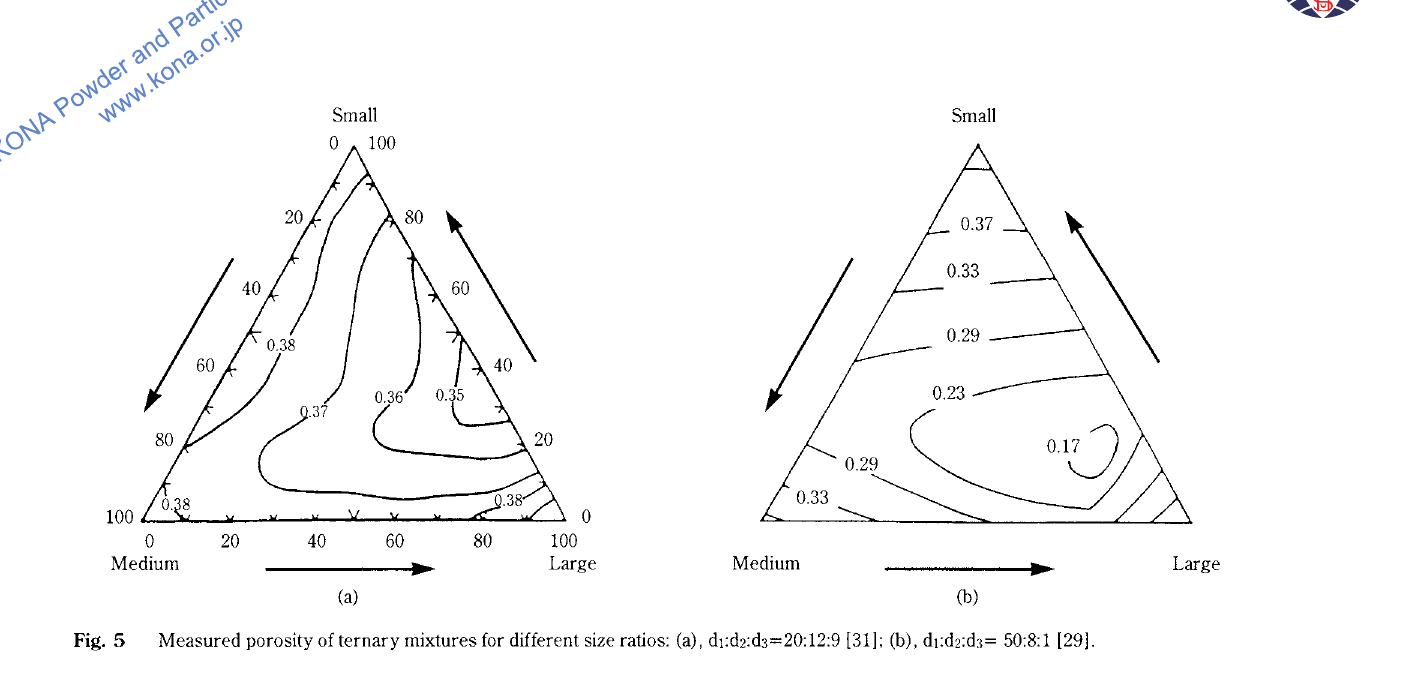
Measured porosity of ternary mixtures for different size ratios: (a), drd2:d3=Z0:12:9 [31]; (b), drd2:d:J= 50:8:1 [29].